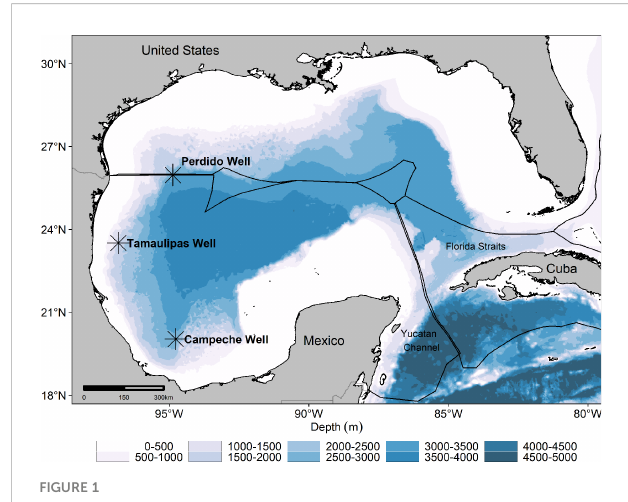
FIGURE 1 Gulf of Mexico and location of the three hypothetical deep-water wells used in our oil exposure risk assessment. Solid line indicates the delimitation of the Exclusive Economic Zones of Mexico, United States and